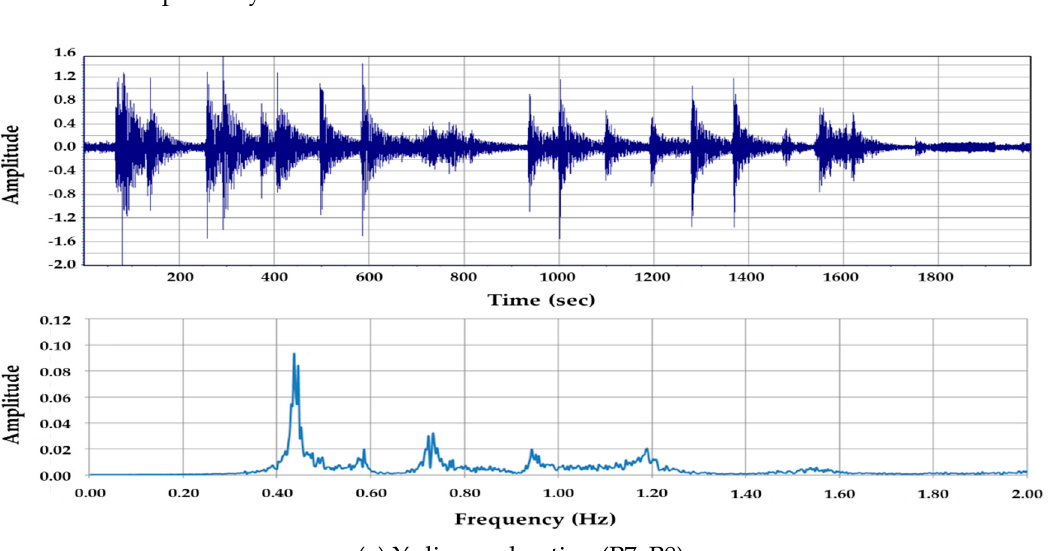
Figure 3. Installation configuration of accelerometer channels (X-axis in longitudinal, Y-axis in transverse, Z-axis in orthogonal). ( a ), ( b ) and ( c ) Acceleration seonsors’ installations for vibration tests.